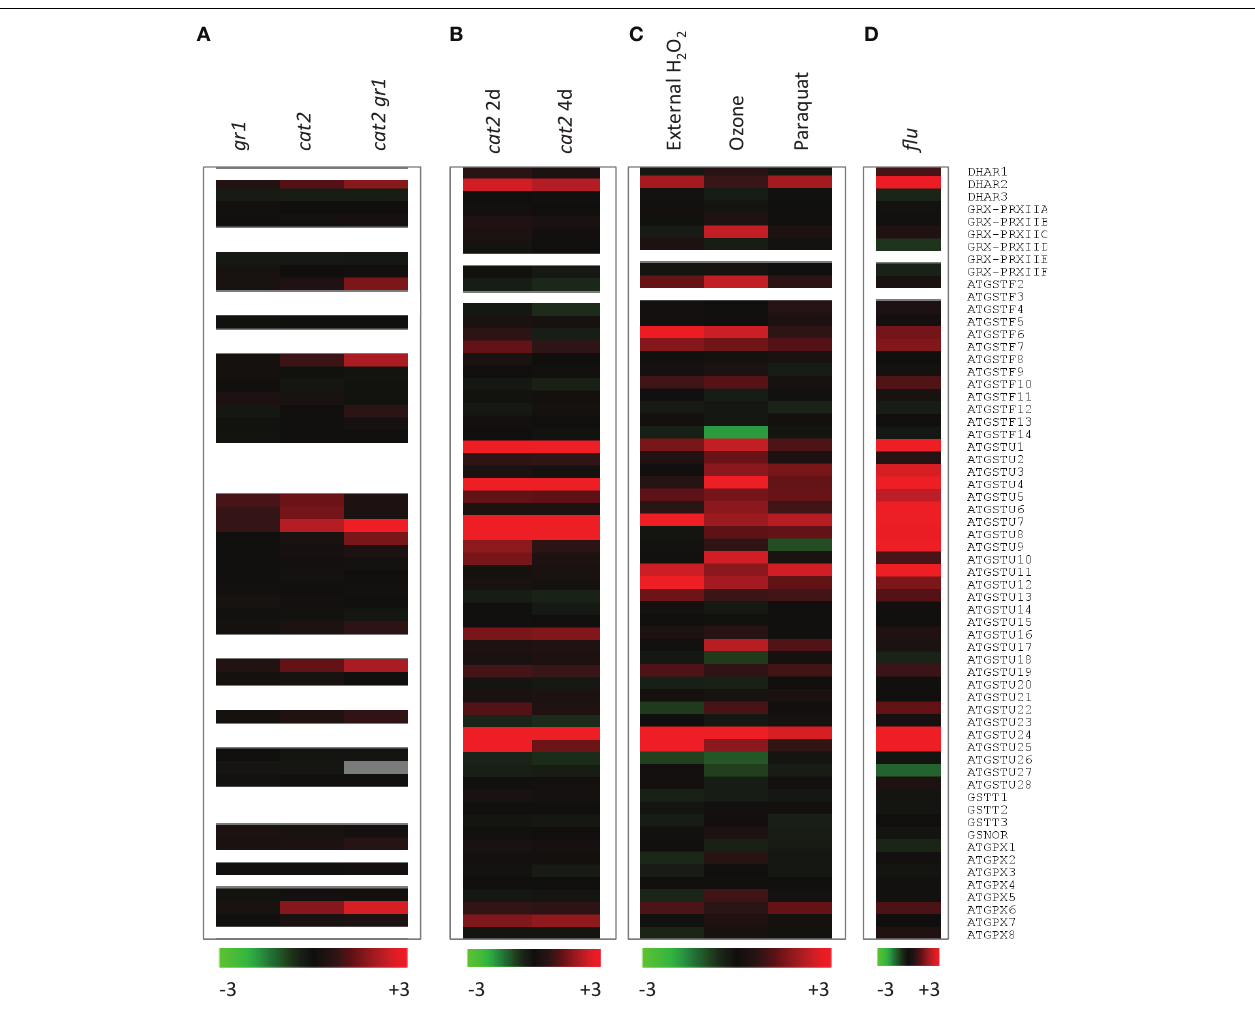
FIGURE 4 | Expression of candidate genes involved in glutathione oxidation in GSSG-accumulating and/or oxidative stress mutants and in conditions promoting oxidative stress. Transcript abundance are shown as log 2 values compared to control (wild-type or untreated). Experimental details are given in Supplemental Table 1. Red and green indicate induction and repression according to the scales shown at the bottom. White rows indicate absence of a corresponding probe set from the array chip. “GRX-PRXII” denotes the signals for the indicated PRX.